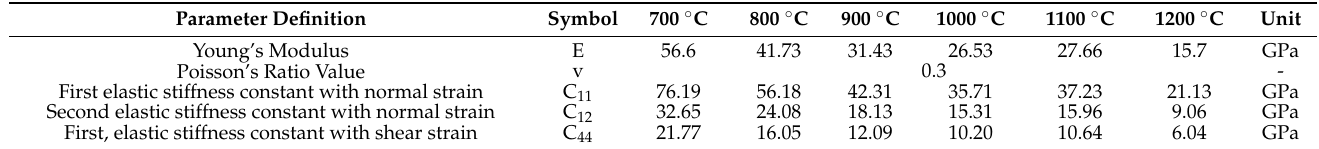
Table 3. The calculated material model parameters for